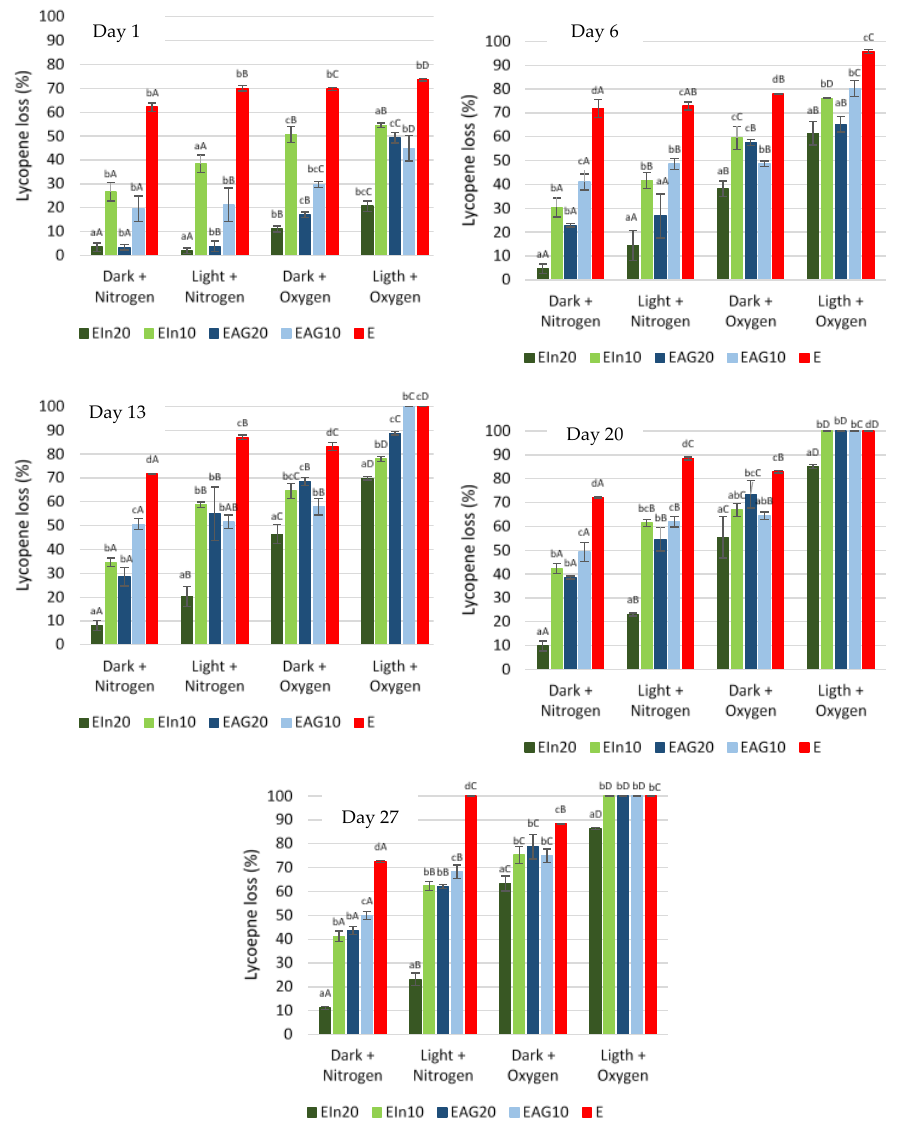
Figure 1. Lycopene loss over the storage period under different conditions. Different letters represent statistically significant differences (Tukey test p < 0.05): uppercase letters (effect of environmental conditions on lycopene loss); lowercase letters (effect of samples on lycopene loss). EIn20–20% Inulin; EIn10–10% Inulin; EAG20–20% Arabic gum; EAG10–10% Arabic gum; E–tomato pomace